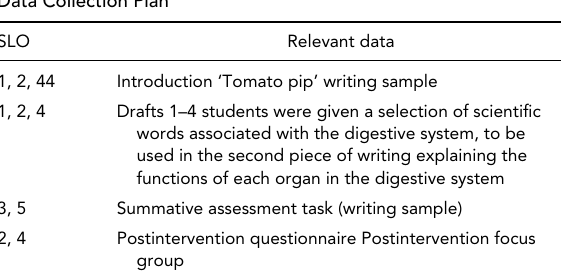
Data Collection